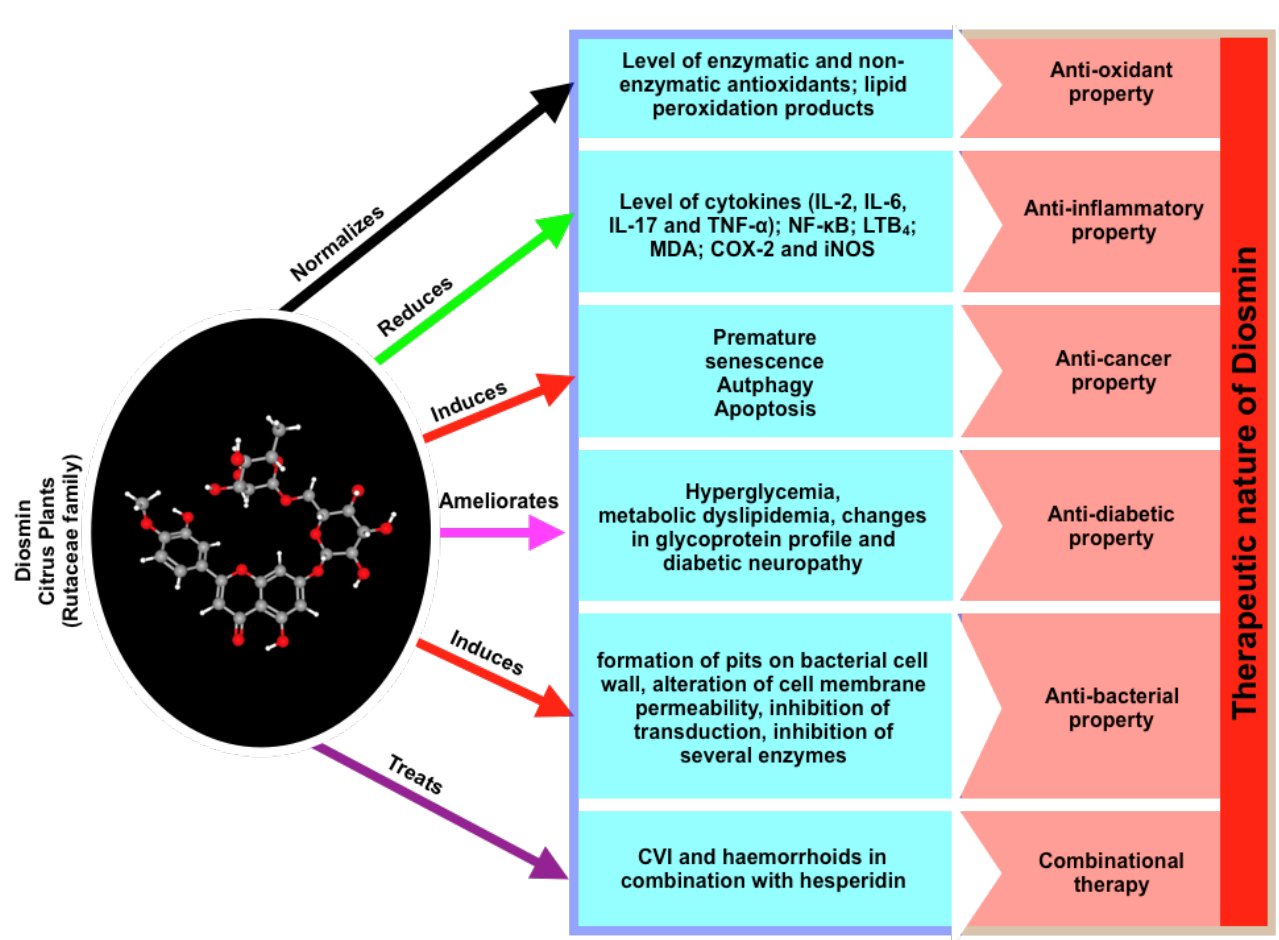
Figure 1. A summary of Diosmin, the associated diseases and potential properties in terms of disease